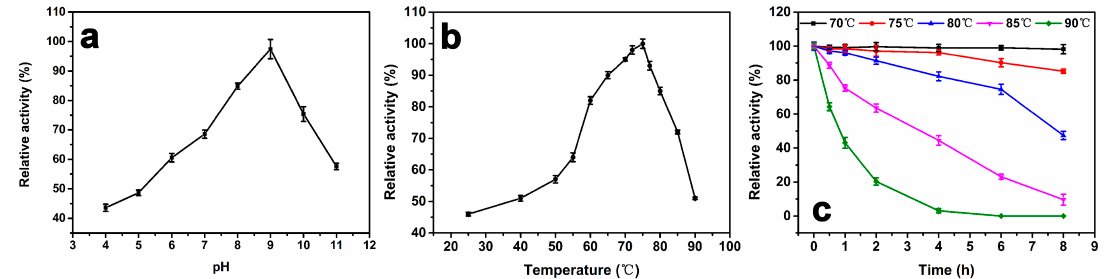
Figure 3. ( a ) The effect of pH on the relative activity of purified GWC. The assays are performed at pHs ranging from 4.0 to 11.0 and a temperature of 25 °C. The maximum activity at pH 9.0 is defined as 100%. ( b ) The effect of temperature on the relative activity of purified GWC. The assays are at pH 8.0, and the temperatures range from 25 °C to 90 °C. The maximum activity at 75 °C is defined as 100%. ( c ) Thermostability test of GWC. GWC solutions at 1 μ g/mL are pre ‐ incubated at different temperatures ranging from 70 °C to 90 °C at pH 8.0 for 8 h. Then the relative activity of each sample is measured at pH 9.0 and 75 °C. The activity prior to incubation id defined as 100% activity. The data points in the plots are expressed as the mean and standard deviation from three independent measurements.